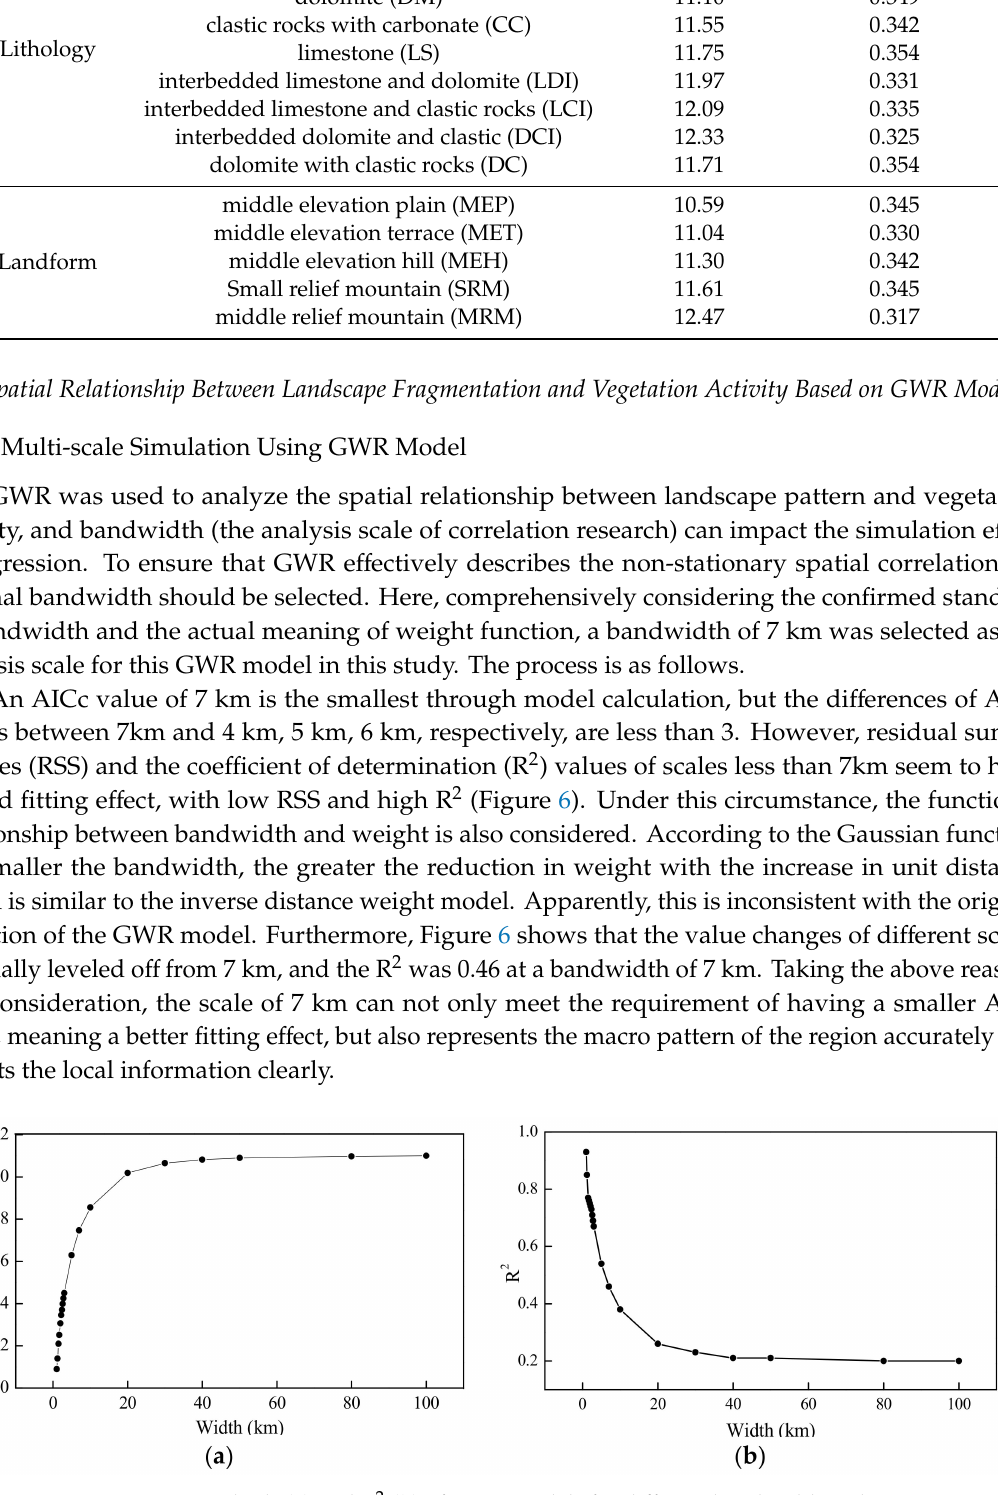
Figure 6. Residuals ( a ) and R 2 ( b ) of GWR models for di ff erent bandwidth